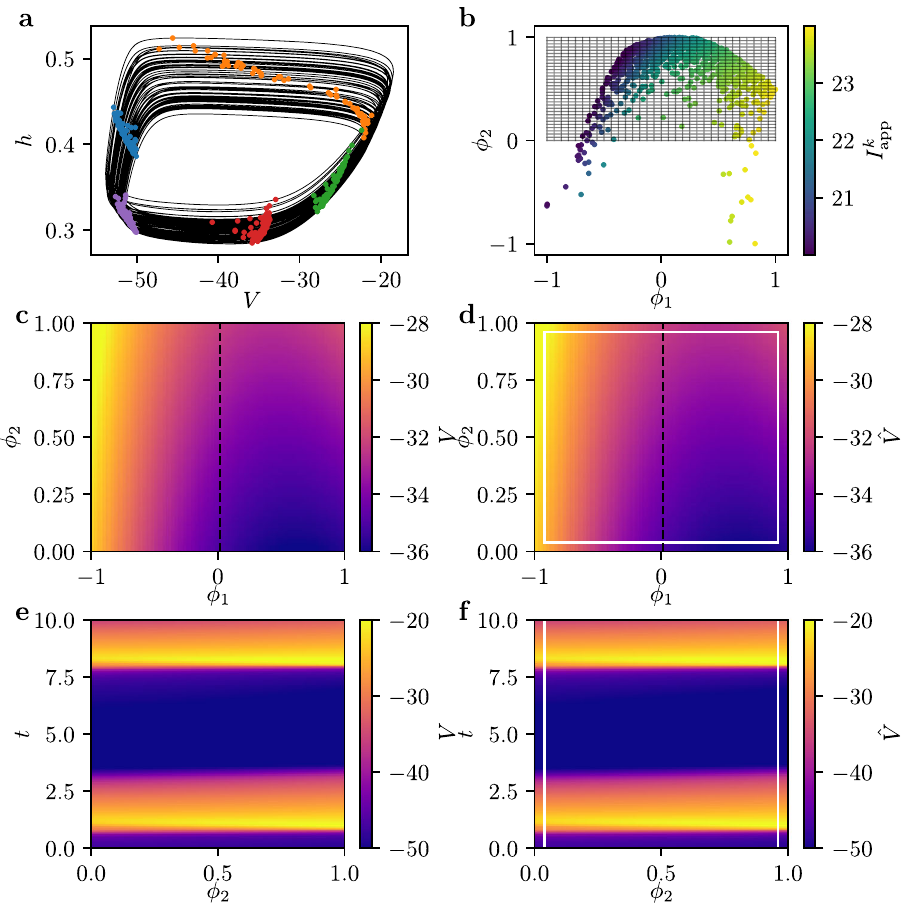
Fig. 5 Emergent PDE for a network of Hodgkin-Huxley like neurons in the pre-Bötzinger complex. a Trajectories of the ensemble and fi ve snapshots (colored points) in the V , h plane of an ensemble of 1024 neurons. For better visability, only 64 trajectories are shown. b The two emergent coordinates ϕ 1 and ϕ 2 . Through the color coding with the intrinsic heterogeneity I k , one can observe that I k is a function of the emergent space coordinates. The app app rectangular grid indicates the space in which we chose to learn an effective PDE. c Snapshot of V at t = 10 obtained by fi tting the simulation data on the grid shown in ( b ). d Snapshot of V at t = 10 predicted by the learned PDE model. e Space-time plot of the evolution of V at the cut ϕ 1 = 0, as indicated in ( c ). f Predictions ^ V of the space-time evolution of V at ϕ 1 = 0. The white lines indicate the borders of the boundary a fi xed point for γ > γ H ≈ 1.75, and to the limit cycle for ≈ 1.75. γ < γ H